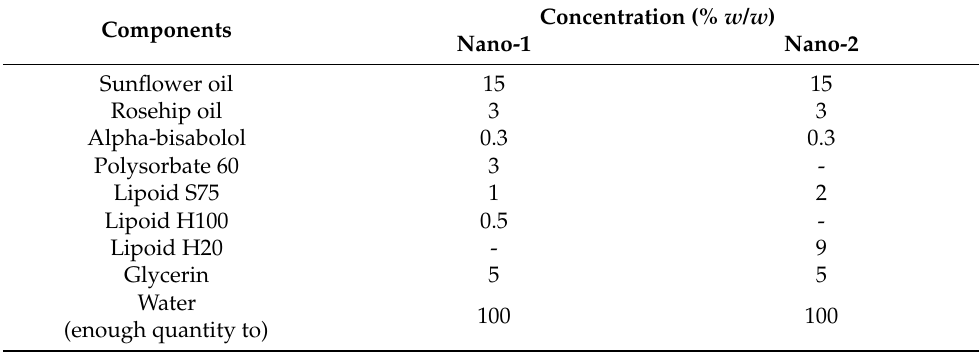
Table 2. Composition of Nano-1 and optimized Nano-2.